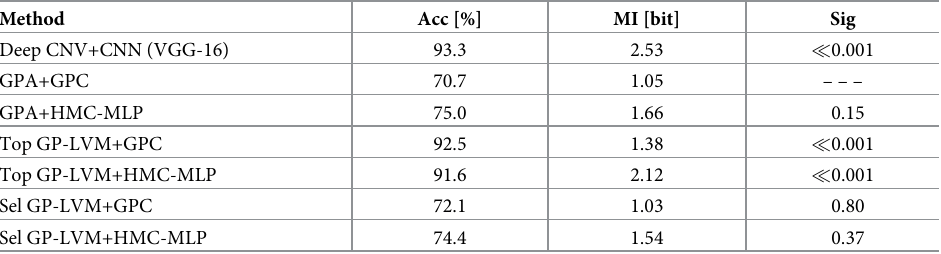
Table 3. Average performance metrics of all tested classifiers.